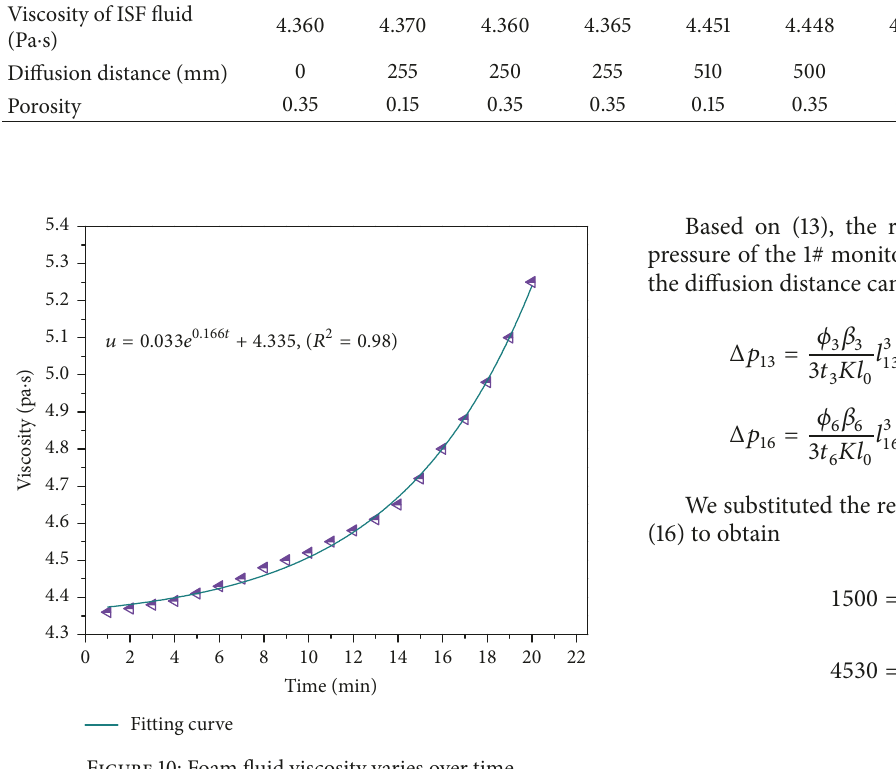
Figure 10: Foam fluid viscosity varies over